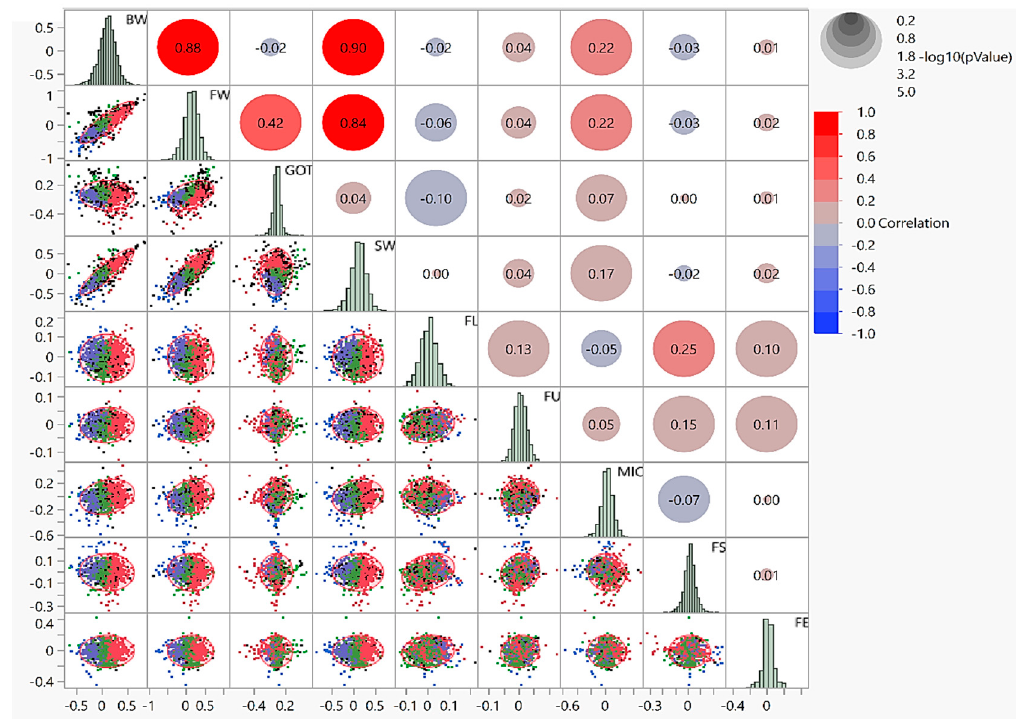
Figure 2. Scatterplot matrix to visualize several attributes by pairwise dependencies of nine fiber quality and yield related traits. The upper triangle matrix represents the correlations among source-sink effects of nine studied traits. Histograms at diagonal depict the shape of frequency distribution for the data of investigated traits, whereas the lower triangle matrix reveals the bivariate density distribution with ellipses between each pair of traits. The legends at the top right corner of the color gradient (red to blue) and the size of circles show the amount of correlation and log p -value for significance threshold, respectively.